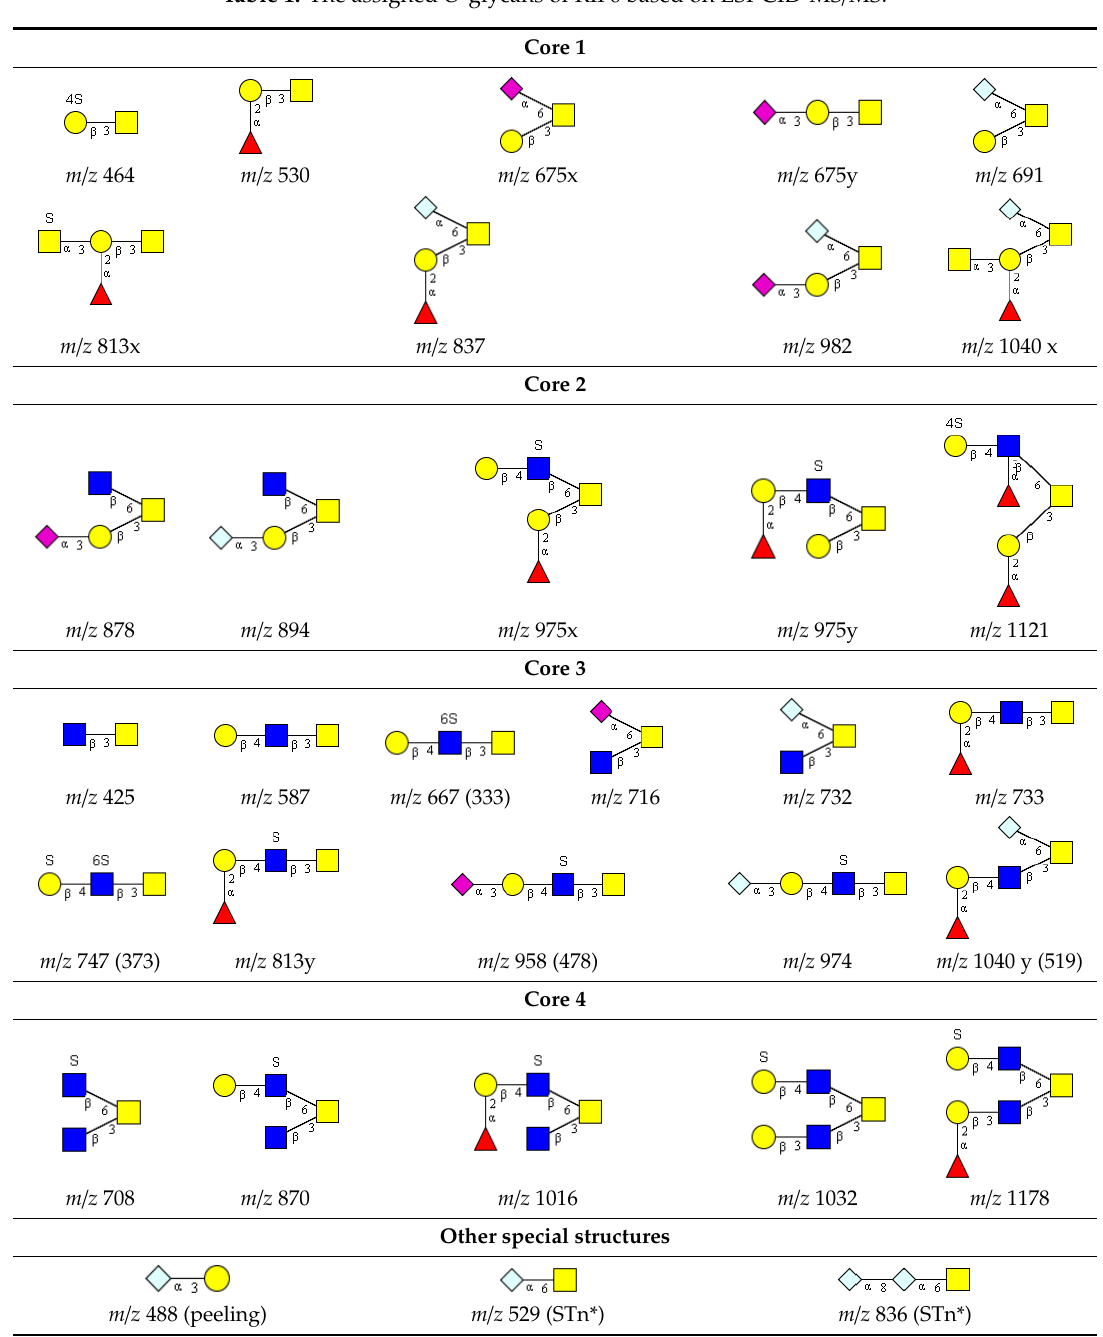
Table 1. The assigned O -glycans of RIF6 based on ESI-CID-MS/MS.